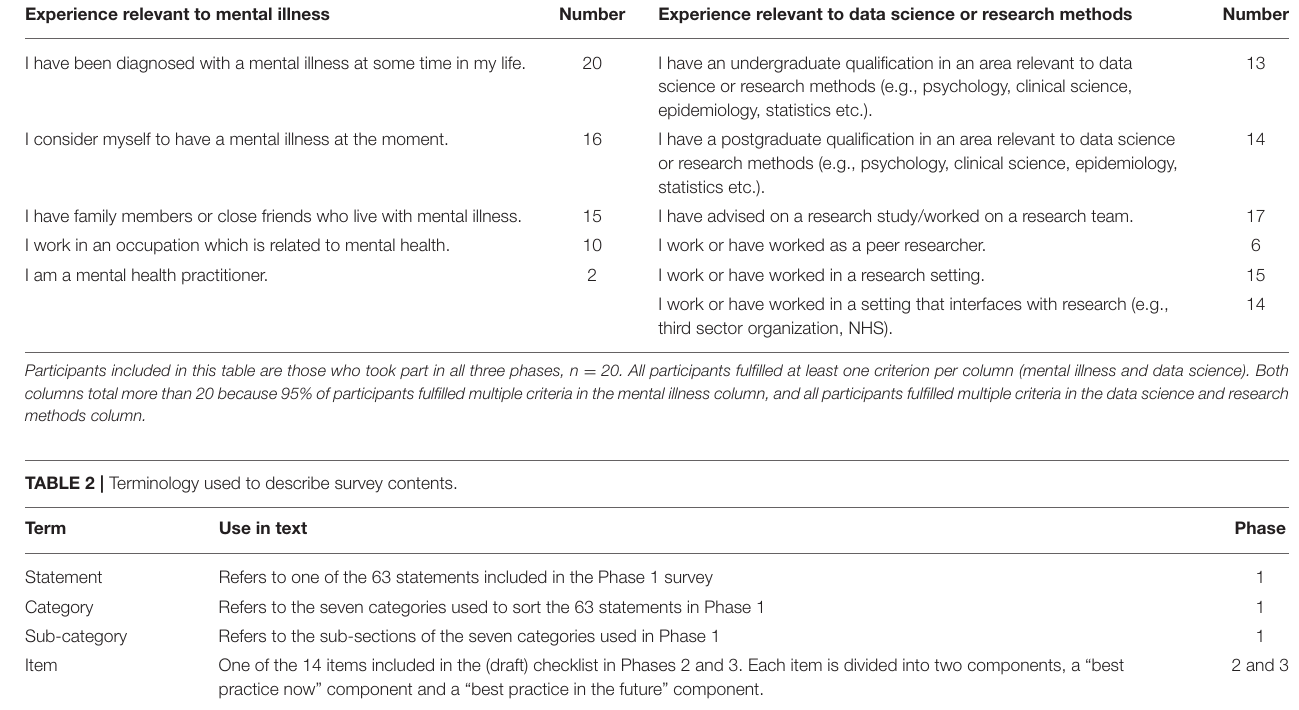
TABLE 1 | Participants’ experience relevant to mental illness and data science or research methods. Experience relevant to mental illness